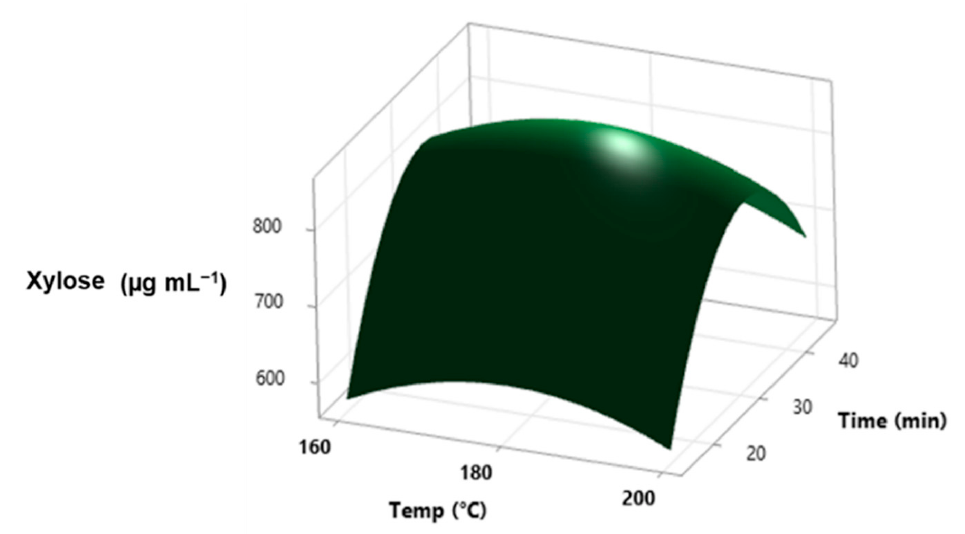
The final compositions of the sugars were optimized using response surface method- ology. The response plot for xylose vs. two different input variables (temperature and time) is presented in Figure 7.